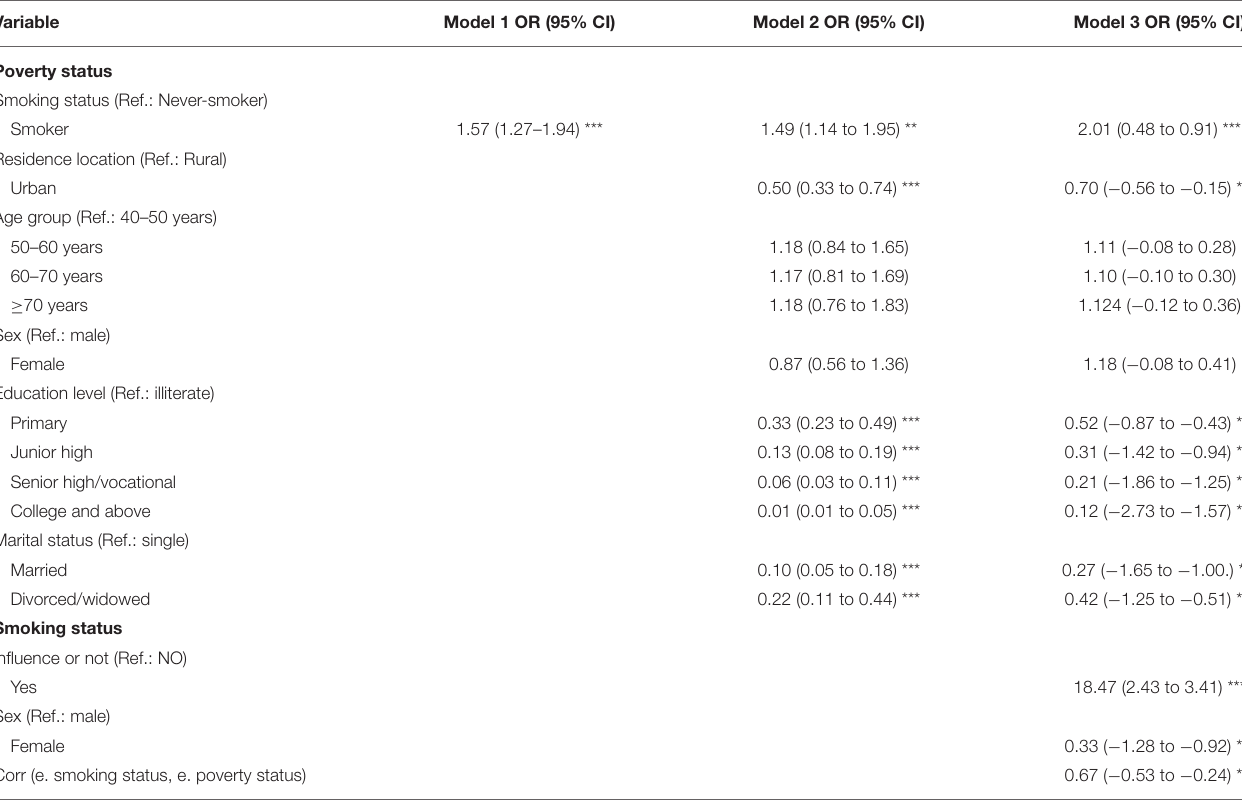
TABLE 2 | Unadjusted and adjusted odds ratios of the association of near-poverty status with householder smoking. Variable